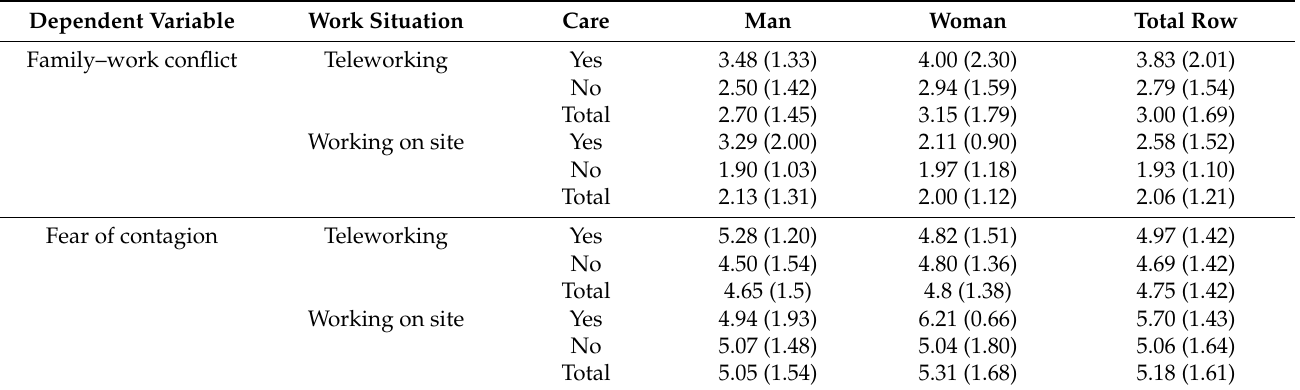
Table 6. Descriptive statistics for statistically significant two-way and three-way interactions. Dependent Variable Work